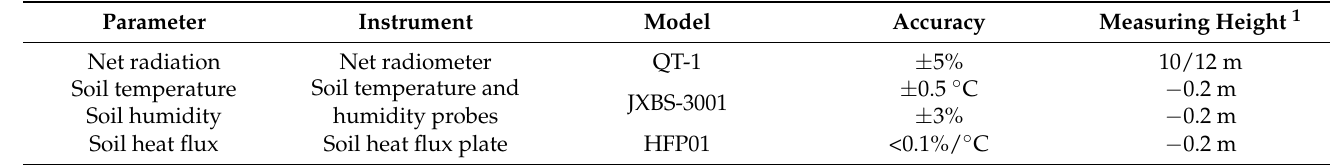
Figure 2. The schematic diagram of the south-facing slope of the study transect in the arbor–shrub– herbaceous community along the Danshui River. Approximate sensor locations are shown with red boxes. A1–A3 are three measuring points of soil heat flux, respectively, and B is the measuring point of net radiation. Table 2. Environmental variables monitored and instruments applied during data